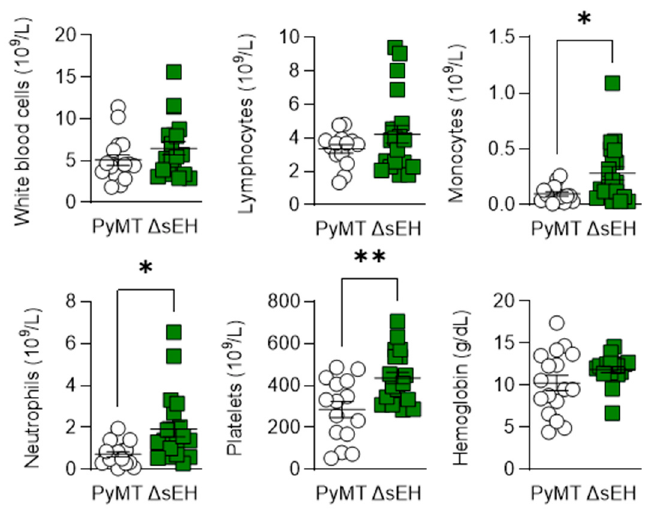
Figure A1. Blood composition of PyMT and PyMT ∆ sEH ( ∆ sEH) mice. Blood was collected from 20-week-old tumor-bearing mice and the blood profiles were analyzed using a cell counter, n = 17–20 animals per group. * p < 0.05, ** p < 0.01 (Student’s t